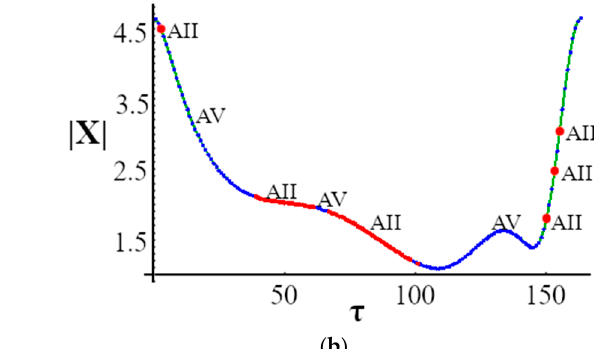
Figure 9. Noise is added to the powershift method using a randomly generated noise for the frequency of the injected signal every 0.4 τ with an amplitude range of ±0.0015 . ( a ) Run 1 and ( b ) Run 2. Note, intermittent access to AII on the every 0.4 τ with an amplitude range of ± 0.0015 . ( a ) Run 1 and ( b ) Run 2. Note, intermittent access to AII on the shoulder of shoulder of the peak at 150 τ compared to Figure 8a without noise. the peak at 150 τ compared to Figure 8a without noise.